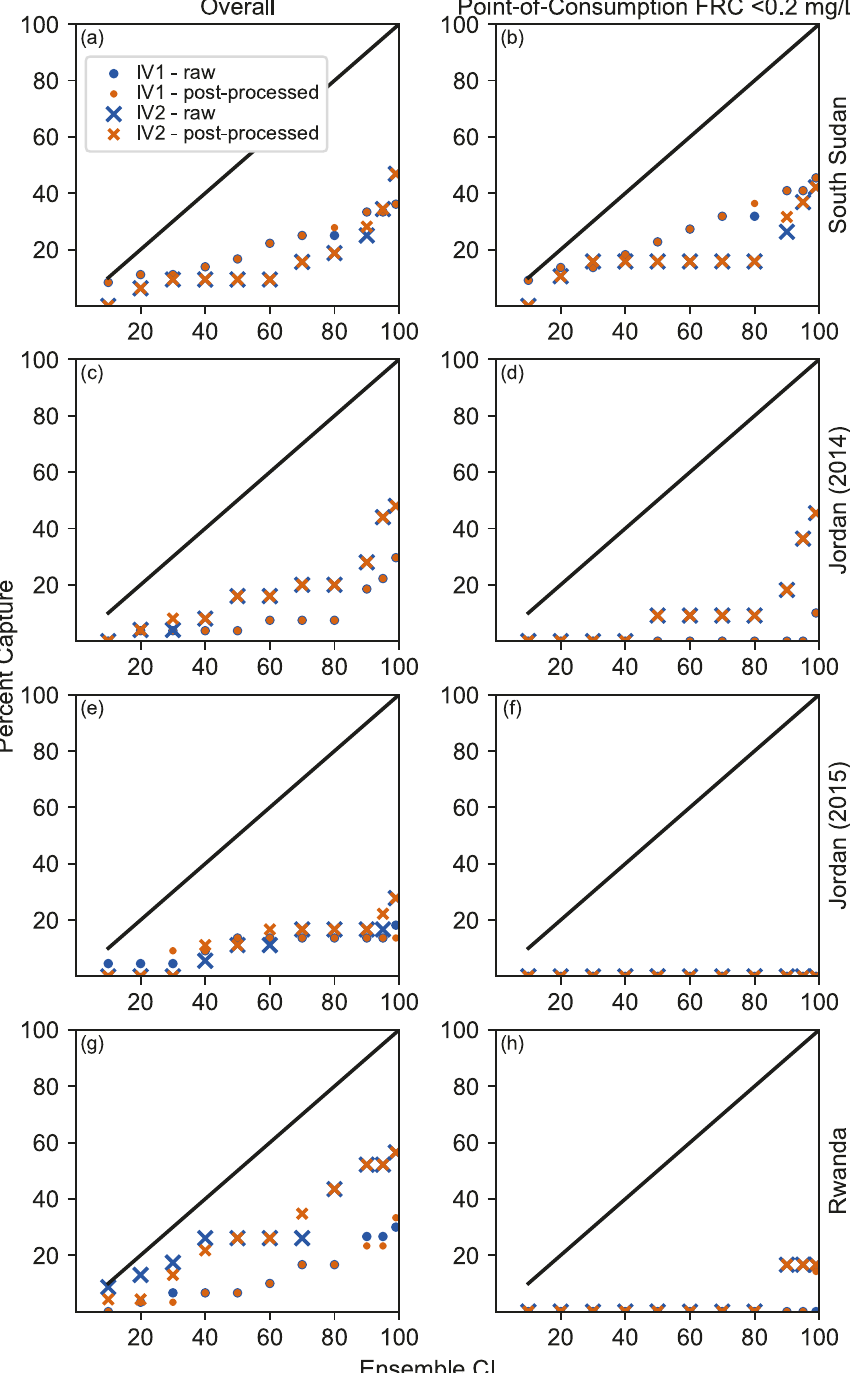
Fig. 2 Con fi dence interval reliability diagrams for all sites. Raw and post-processed CI reliability diagrams for all sites for both the overall dataset ( a South Sudan, c Jordan (2014), e Jordan (2015), g Rwanda) and for observations where point-of-consumption FRC is below 0.2 mg/L ( b South Sudan, d Jordan (2014), f Jordan (2015), h Rwanda). All ensembles have percent capture below the 1:1 line, indicating underdispersion at all CI ’ s, though better reliability is observed for models using the IV2 input variable